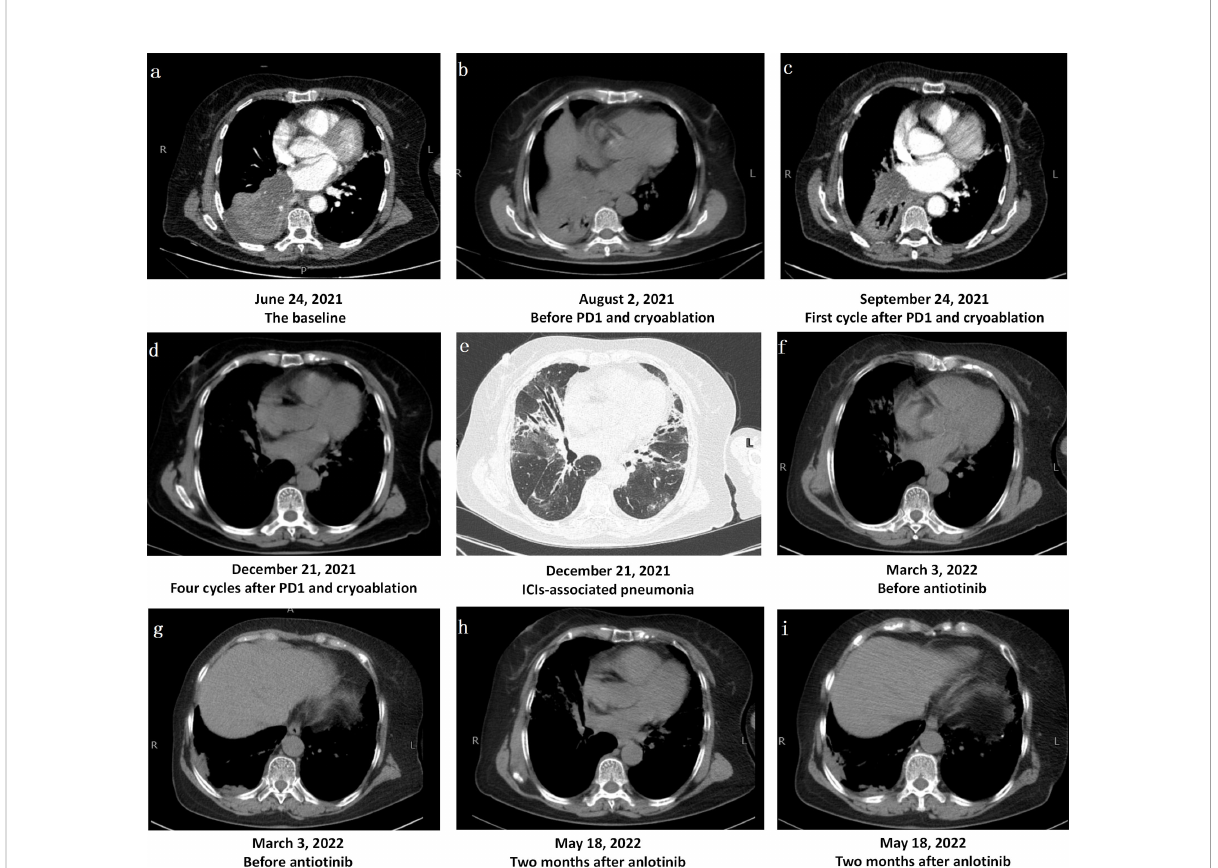
FIGURE 1 Changes in Computerized Tomography Images. (A) The bronchus of the lower lobe of the right lung was truncated from hilus of lung, and the basal segment of the lower lobe of the right lung was clumped with consolidation shadow and obstructive atelectasis. (B) Obstructive pneumonia and atelectasis were worse after one-cycle treatment of bevacizumab combined with albumin-bound paclitaxel and carboplatin. (C, D) The mass in the lower lobe of the right lung was signi fi cantly reduced, obstructive pneumonia and atelectasis were signi fi cantly improved after PD1 and chemotherapy. (E) After treatment, there were multiple consolidation shadows, ground glass shadows and interstitial changes in chest CT, which was considered as immune checkpoint inhibitor-associated pneumonia. (F, G) . After three months of methylprednisolone administration, the tumor near the pleura in the lower lobe of the right lung progressed slightly, and the immune pneumonia was not completely resolved. (H, I) After anlotinib treatment, the tumor near the pleura in the lower lobe of the right lung was